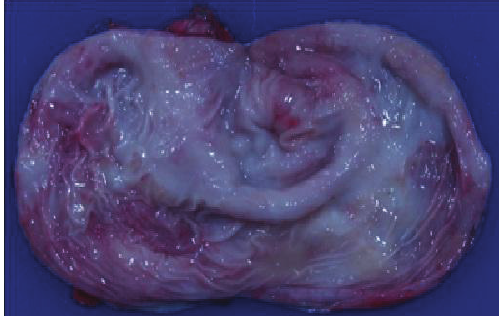
Figure 2: Inner surface of specimen was smooth and white-pink in color with a 1.5 × 1.2cm rough area.